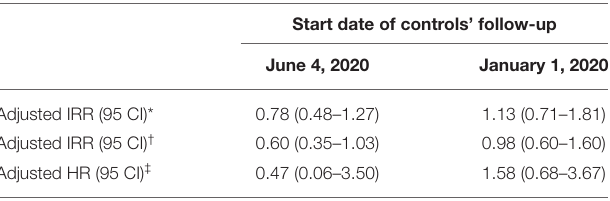
TABLE 2 | Results of log-link Poisson regression and Cox proportional regression by the different start dates of follow-up of